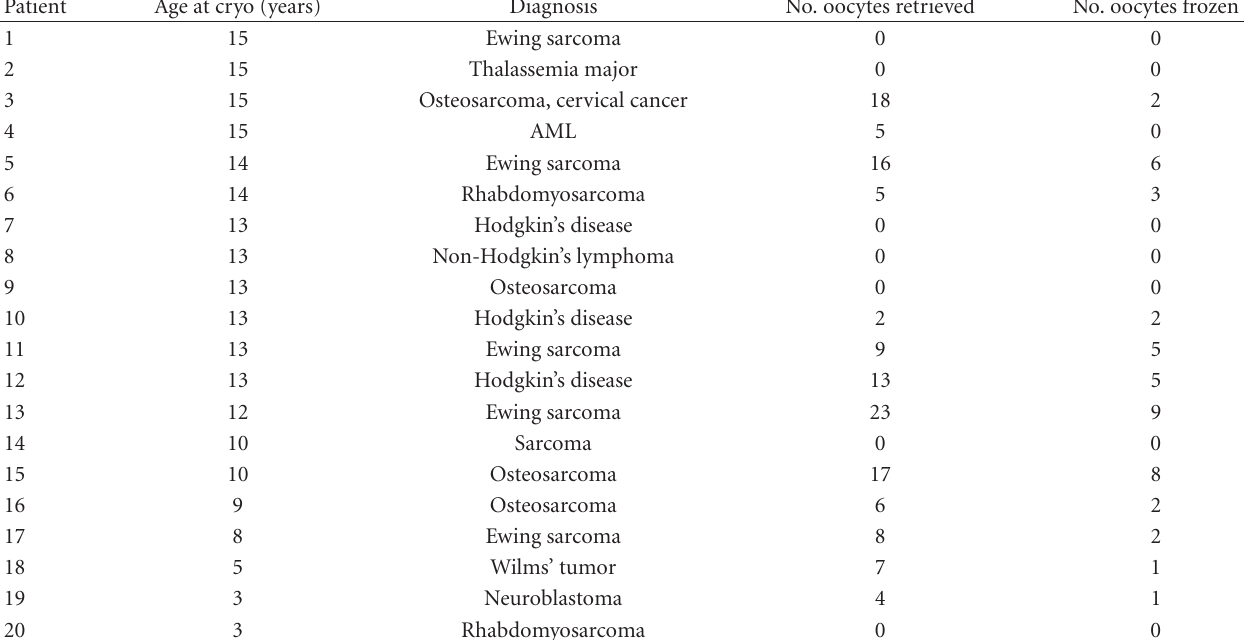
Table 1: Ovarian cryopreservation in pediatric patients, Hadassah Medical Center